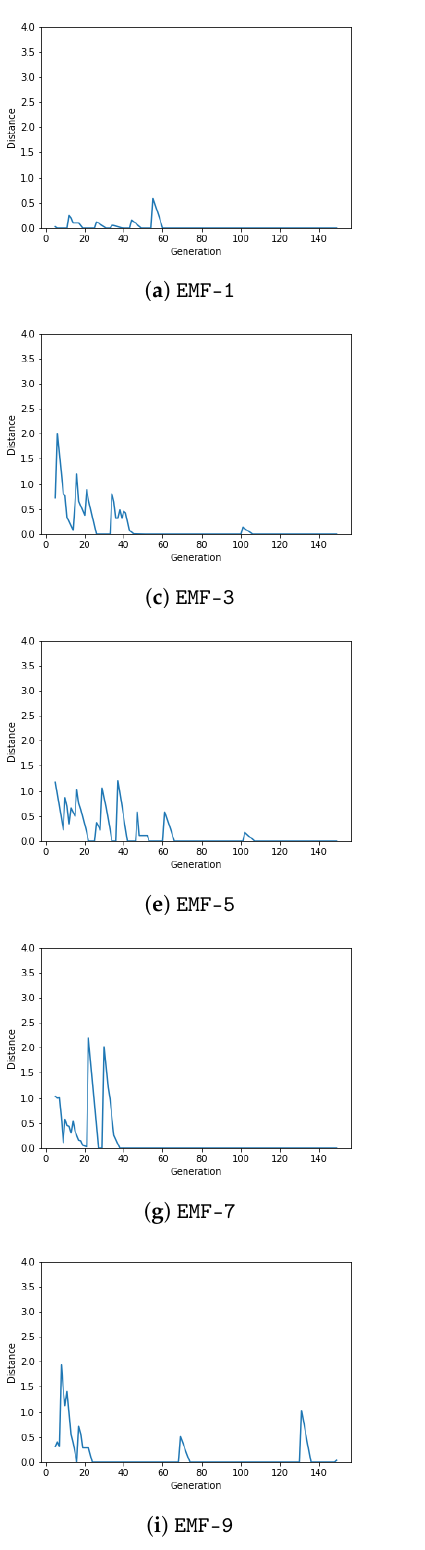
Figure 6. Convergence of the evolutive method on the FilmTrust dataset. The plots show the moving average distance D 5 ( n ) with window width W = 5 and p = 2 during the 150 generations of the 10